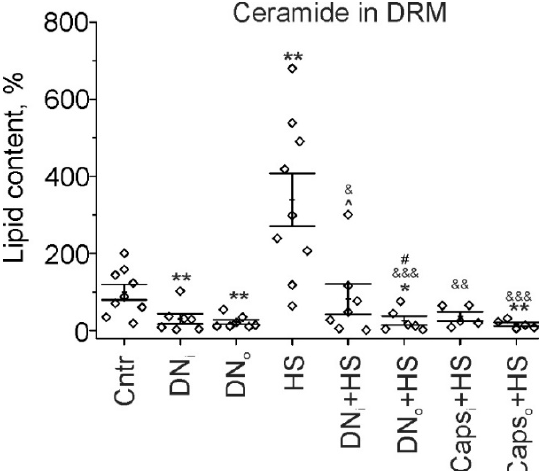
Figure 4. Cer content in DRM fraction. Cer levels in control (Cntr), after unilateral denervation (DN)/Caps treatment (Caps) itself and in combination with HS are shown. Data are represented as mean ± SEM; diamonds are individual values; N = 5 − 9 per group. * p < 0.05, ** p < 0.01—differences compared to control; & p < 0.05, && p < 0.01, &&& p < 0.001—differences compared to HS; # p < 0.05—differences between intact and operated limb, ^—differences between HS and HS+DN i . p was evaluated by a Kruskal–Wallis and Mann–Whitney tests. DN i , Caps i and DN o , Caps o —intact and operated limb, respectively.